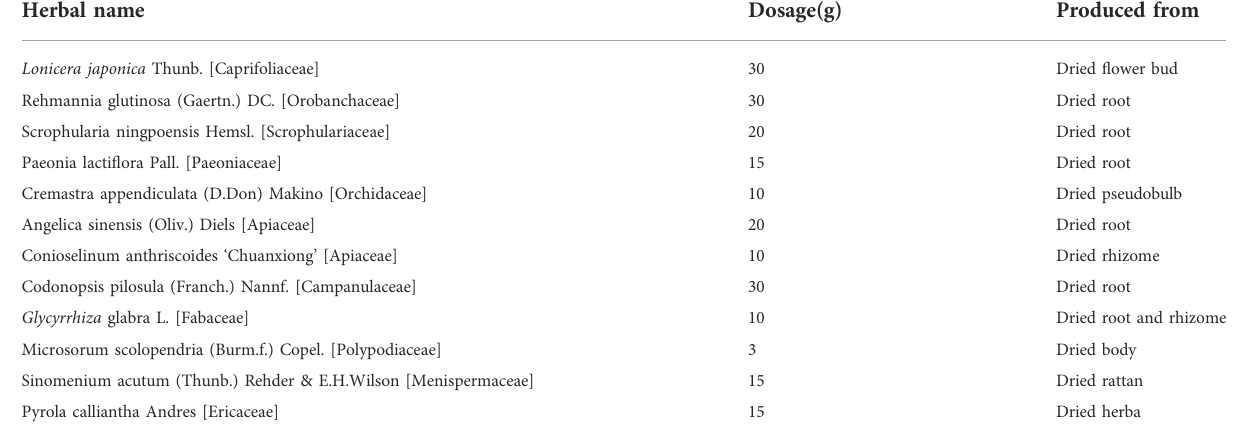
TABLE 1 The components of the Chinese herbal formula Kunbixiao. Herbal